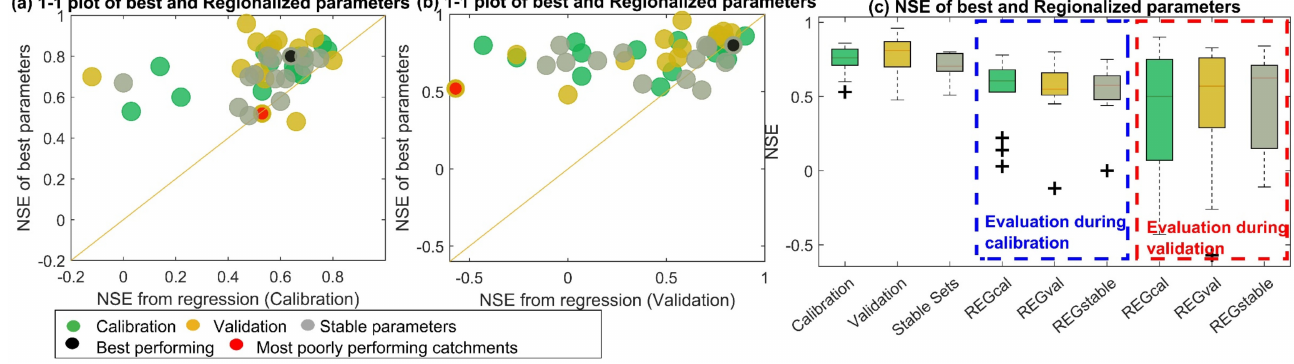
Figure 5. Evaluation of the regression procedure on the calibration (1995–2002) and validation period (2003–2007), showing ( a , b ) the relationship of the NSE of the best-estimated parameters (from calibration, validation, and stable parameters set) and the parameters from the regression. The black and red scatter indicate the best and most poorly performing catchments, respectively. ( c ) Shows the performances of best-estimated parameters (from calibration, validation, and stable sets) and the performance of the three regression models developed using the best parameters of calibration (REGcal), validation (REGval), and stable sets (REGstable) while evaluated during the calibration and validation